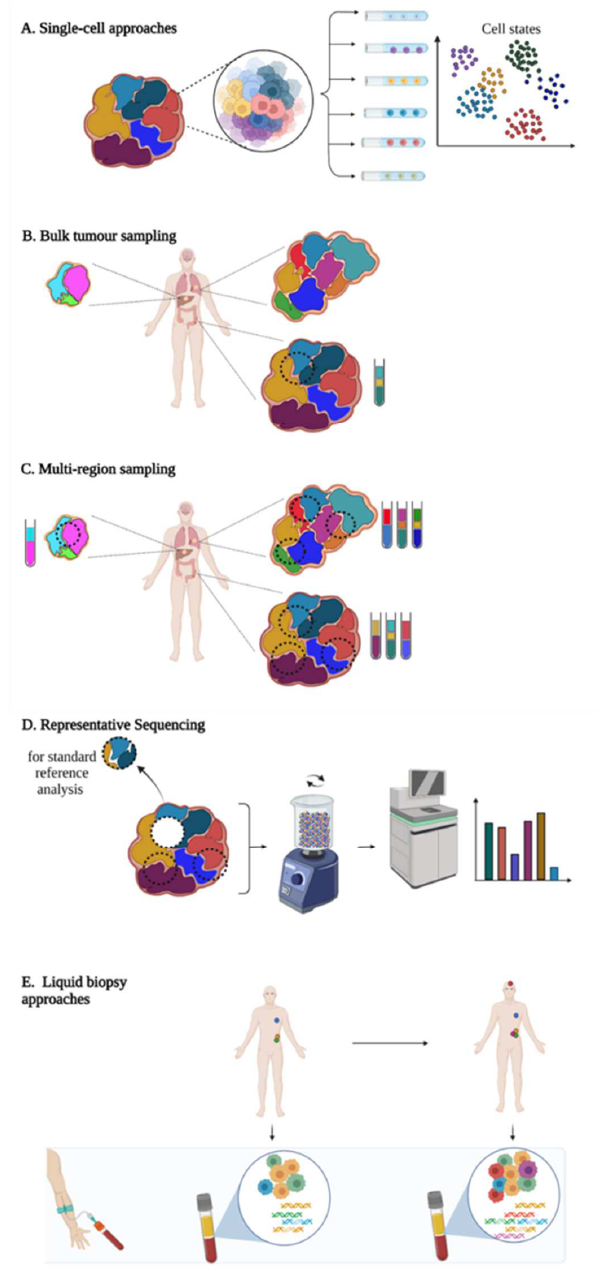
Figure 4. Emerging approaches to capture intra-tumour heterogeneity (ITH). ( A ) Single-cell ap- proaches profile the characteristics of each cell individually. Compared to bulk-tumour sampling ( B ), multi-region sequencing ( C ) measures cellular heterogeneity in distinct regions of the primary site and of the metastases and/or tissue biopsy samples collected at different time points of the dis- ease. ( D ) Representative sampling (Rep-Seq) implies the analysis of a mixed solution composed of tumour residual material that has not been used for standard pathologic procedures. ( E ) Liquid biopsy consists in the analysis of tumour-derived components shed in body fluids.